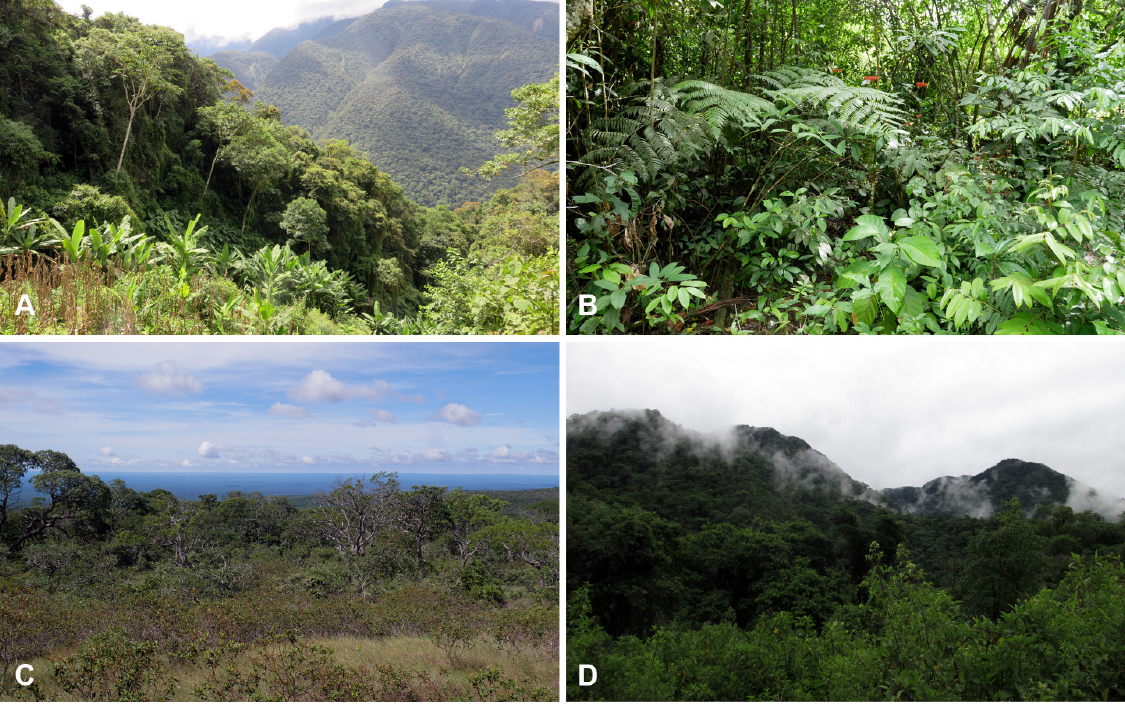
Fig. 2. Examples of sampled habitat types. A . Bolivian Yungas forest (forest edge) in Villa Teresa,